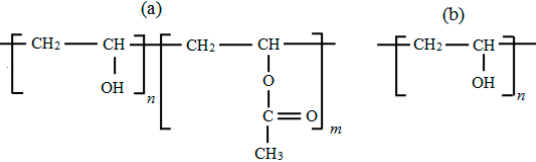
Figure 1. Structural formula for PVA: ( a ) partially hydrolyzed; ( b ) fully hydrolyzed [2].